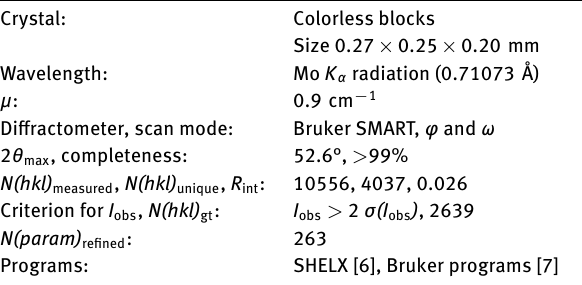
Table 2: Fractional atomic coordinates and isotropic or